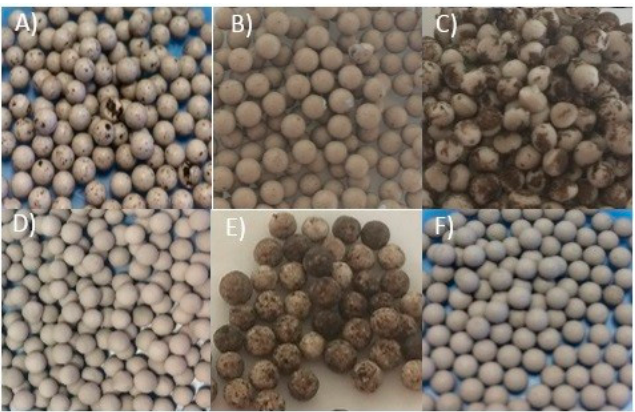
Figure 1. Appearance of the homogeneously dispersed catalysts: ( A ) CP-DI-Ea, ( B ) CP-WI-Ea, ( C ) RP-DI-Ec, ( D ) CP-DI-Ab, ( E ) RP-DI-Aa, and ( F ) RP-DI-Ab.